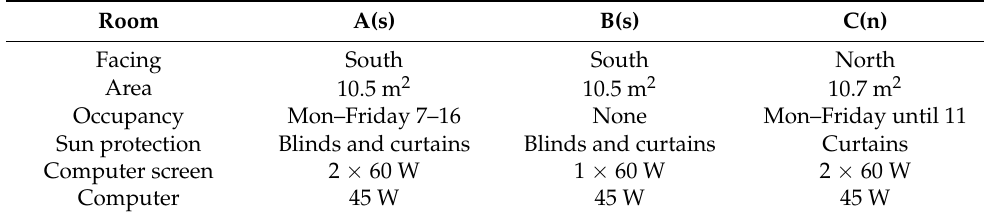
Table 1. Room data and general information.